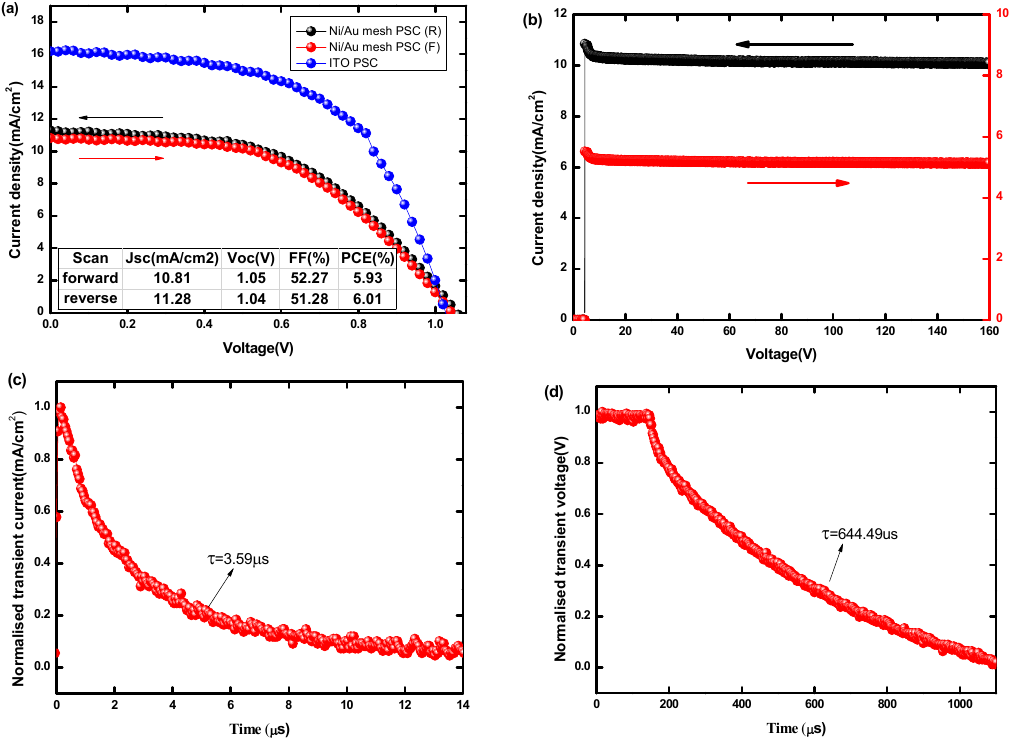
Figure 8. ( a ) J ‐ V curves in forward and reverse scans for large ‐ area PSCs based metal mesh, ( b ) steady Figure 8. ( a ) J-V curves in forward and reverse scans for large-area PSCs based metal mesh, ( b ) steady output characteristics curve, ( c ) TPC and ( d ) TPV decay curves. output characteristics curve, ( c ) TPC and ( d ) TPV decay